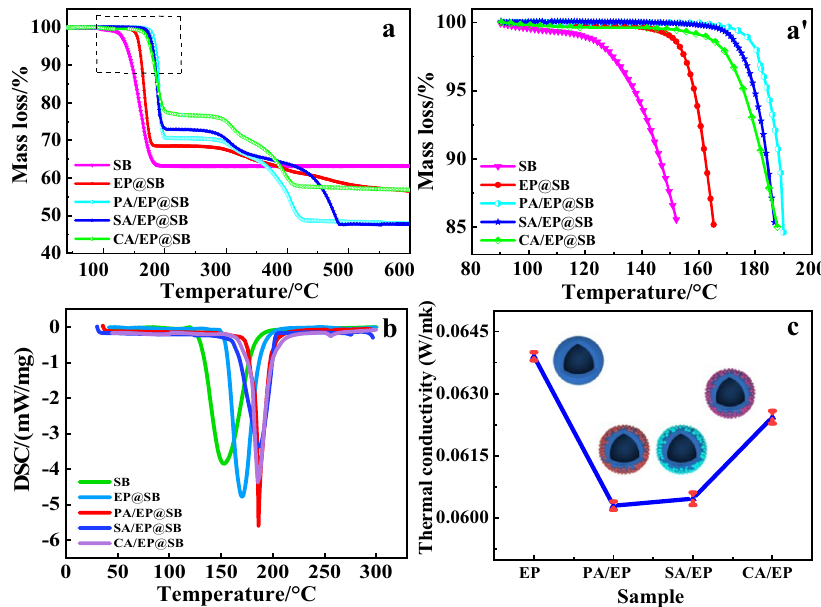
Figure 3: ( a and a ′ ) TG curves of the SB - based capsules. ( b ) DSC curves of the SB - based capsules. ( c ) Thermal conductivity of the EP and PA/EP, SA/EP, and CA/EP.